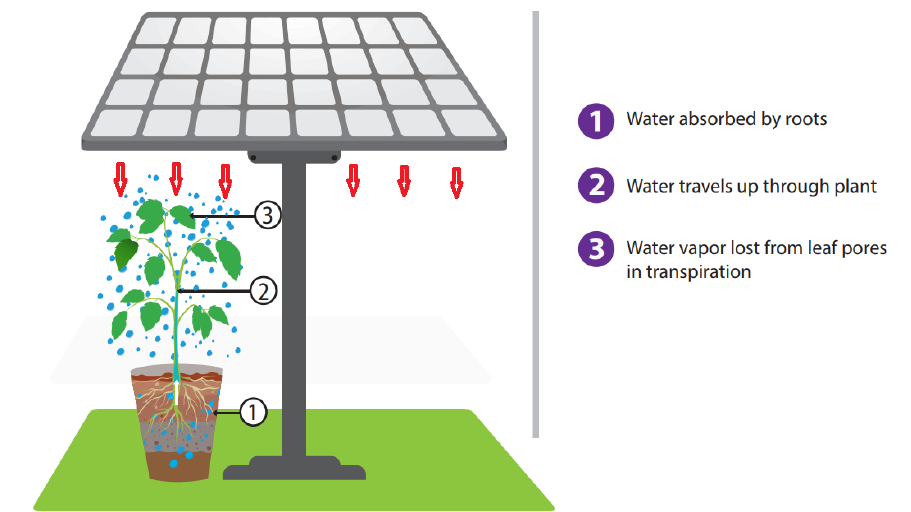
Figure 2. A simple analogy of the plant transpiration process directly underneath a photovoltaic (PV) module (heat source). Original source from [34].